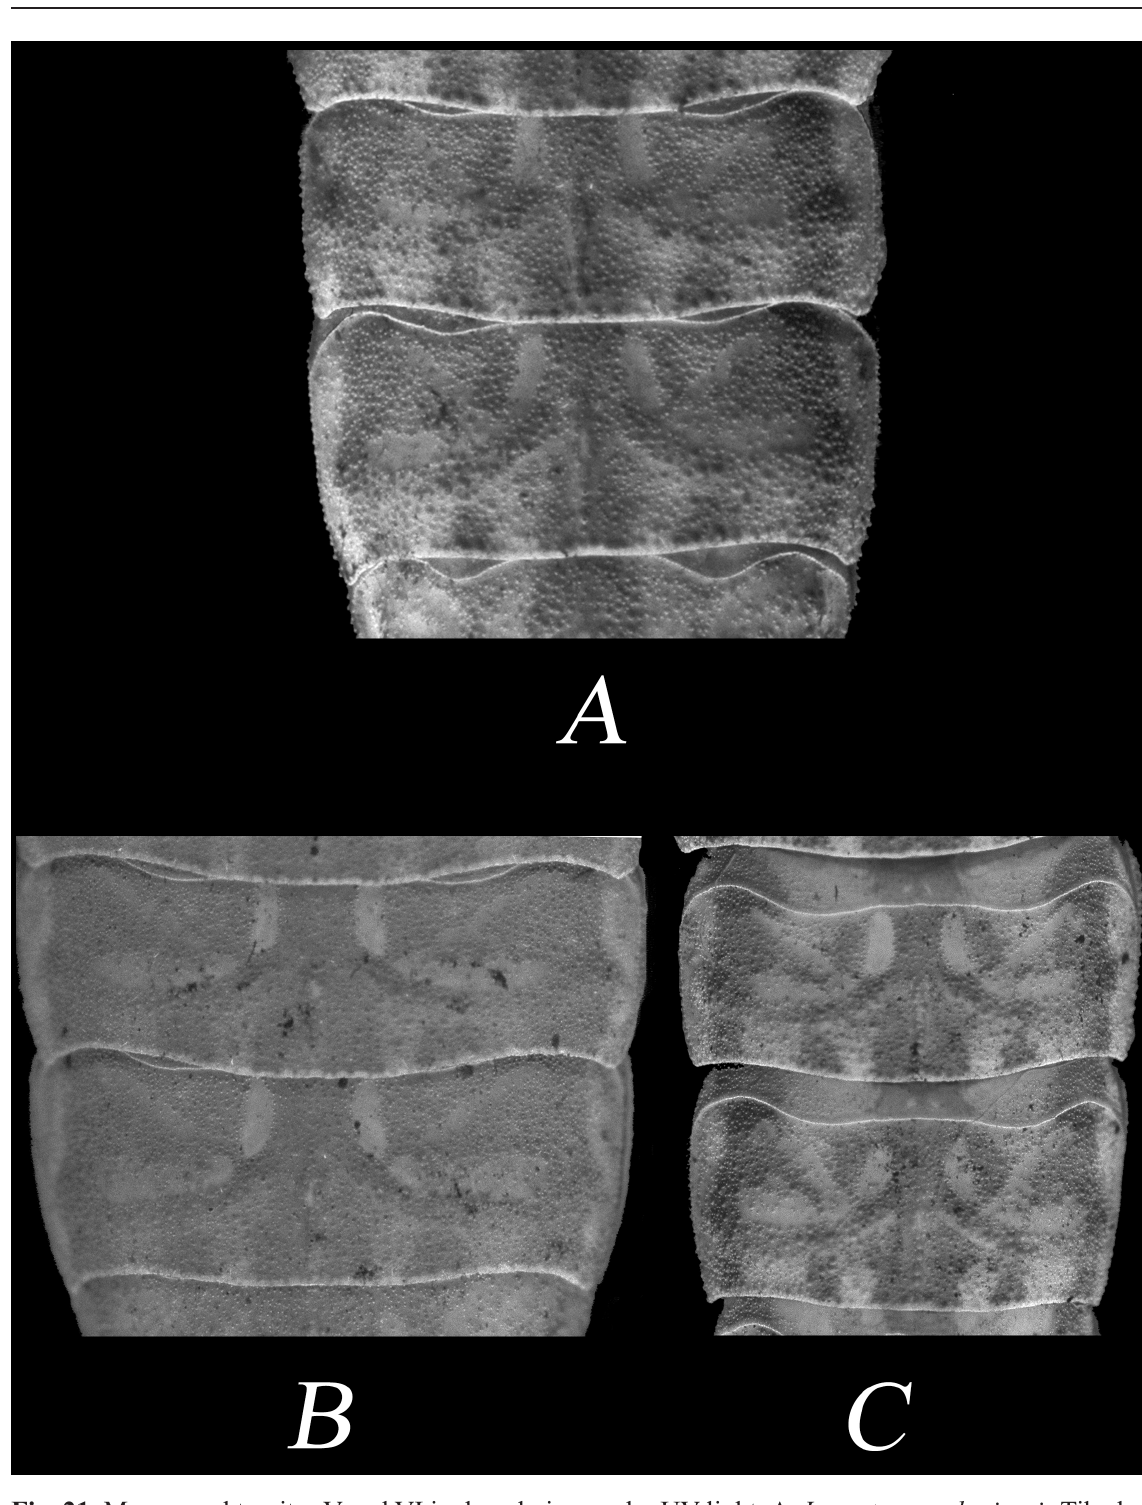
Fig. 21. Mesosomal tergites V and VI in dorsal view under UV light. A . Isometrus sankeriensis Tikader & Bastawade, 1983, neotype, adult ♂ (BNHS SC 194). B . I. nakshatra sp. nov., holotype, adult ♂ (BNHS SC 195). C . I. wayanadensis sp. nov., holotype, adult ♂ (BNHS SC